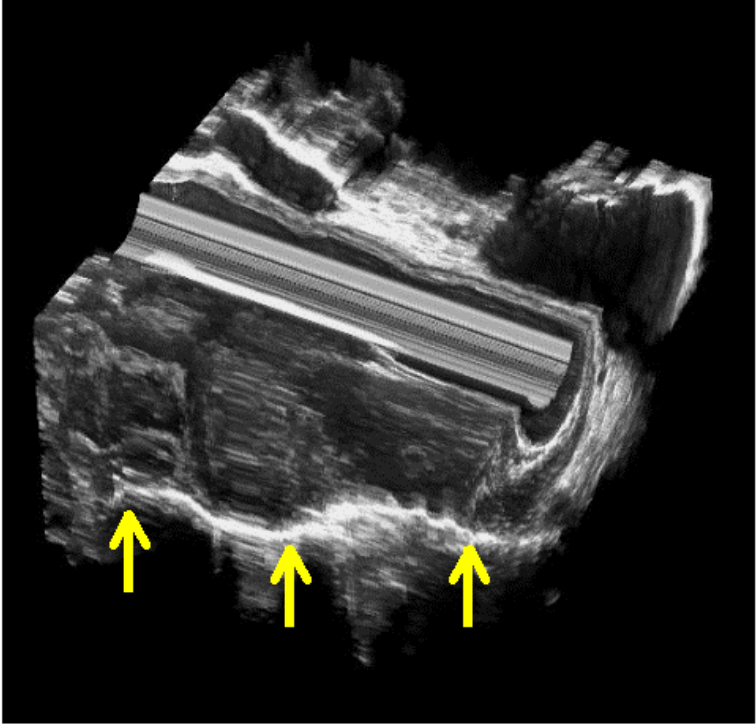
FIGURE 2. Three-dimensional reconstruction of an esophageal cancer usT4 (pleura involvement: arrows) using a radial electronic probe (Pentax-EG